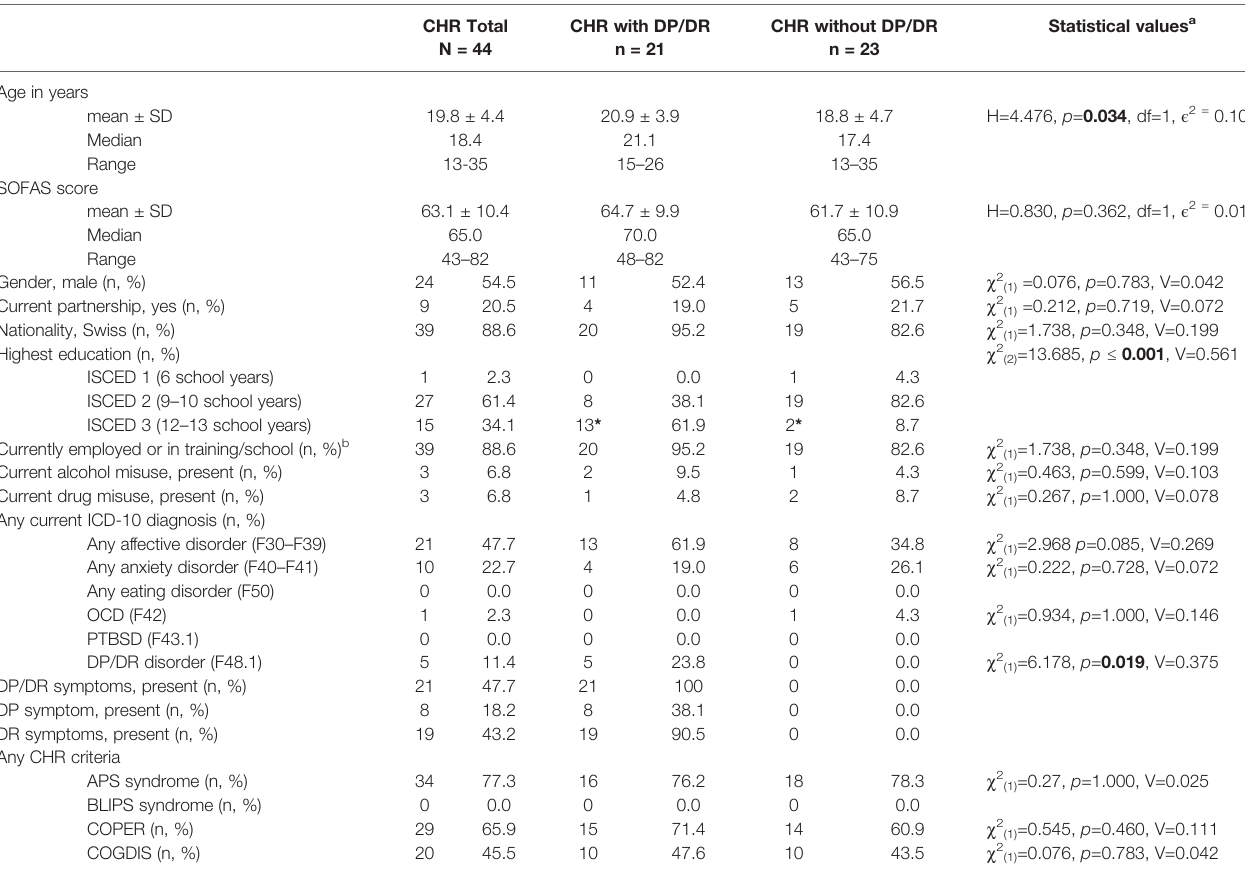
TABLE 2 | Sociodemographic and clinical characteristics of clinical high risk (CHR) subjects for psychosis with and without DP/DR with available MRI